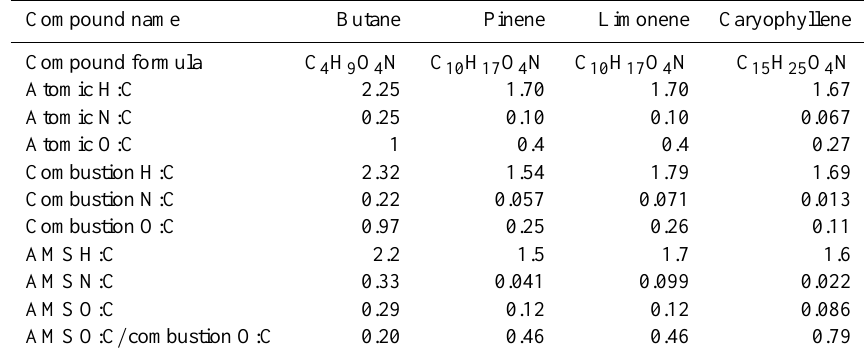
Table 1. H/C, N/C and O/C data from combustion elemental analysis and AMS elemental analysis. Compound